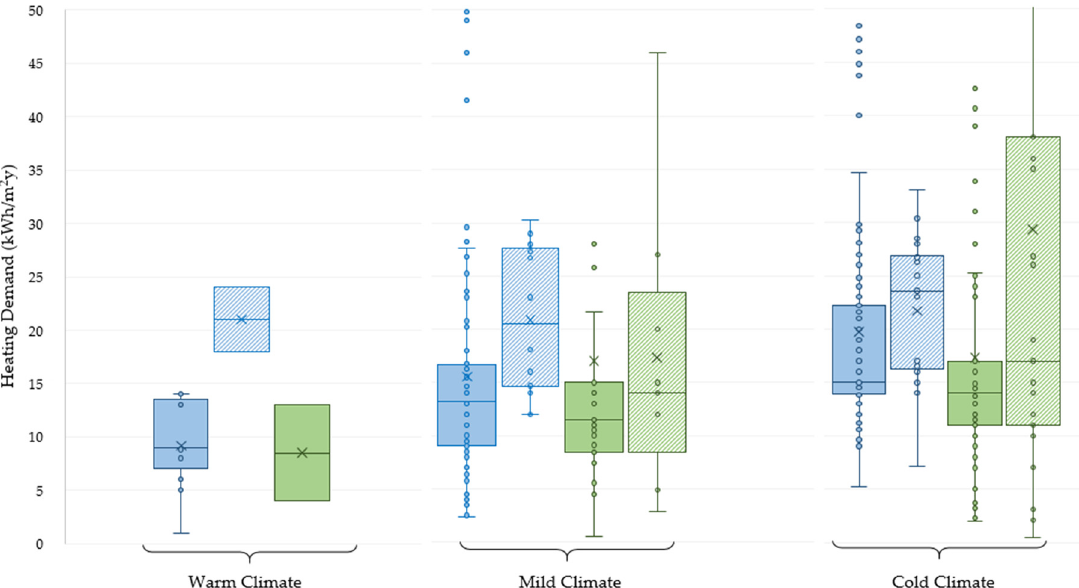
Figure 4. Heating demand of nZEBs according to use (residential and non-residential) and type of construction (new and renovated) for different climate condition. Note: in warm climates for both renovated residential and new non-residential buildings, the limits of the interquartile ranges (central rectangle) correspond to the only two values of Heating Demands of the collected nZEBs.